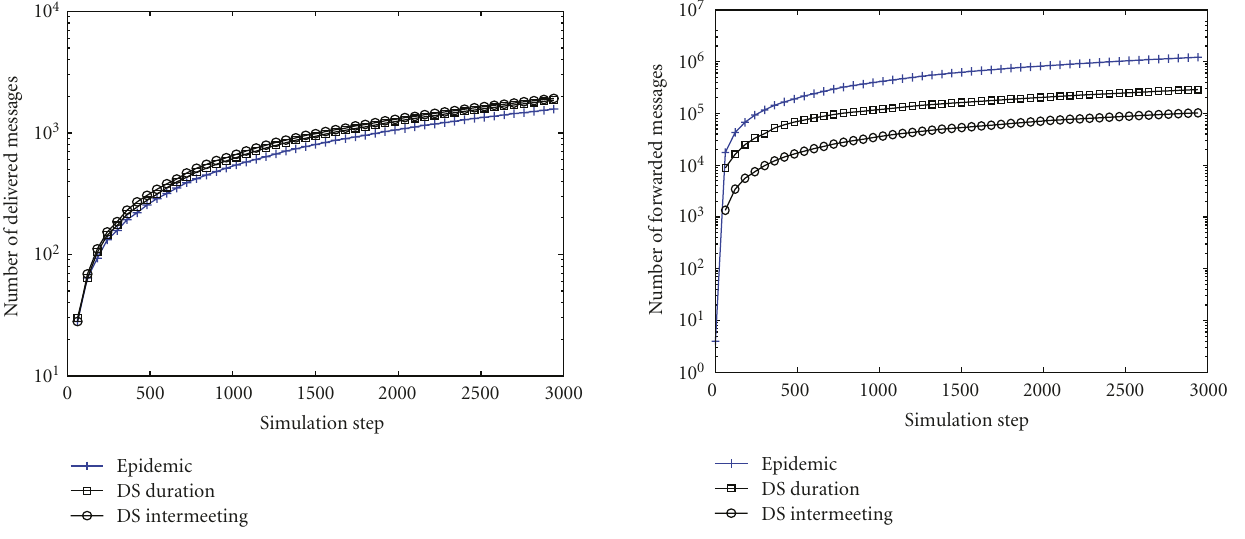
Figure 4: Number of delivered messages under di ff erent routing schemes.